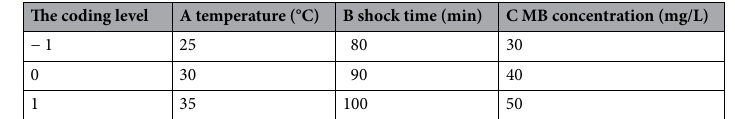
Table 1. Three Factors Levels and Codes of Box-Behnken Design.